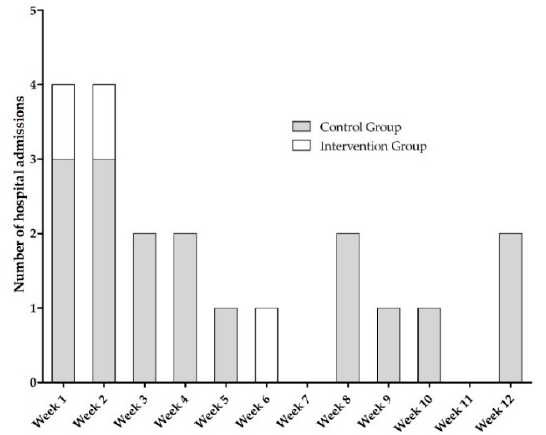
Figure 2. Number of OAT-related hospitalizations and their date of occurrence within AMBORA. Abbreviations: OAT, oral anticancer treatment.